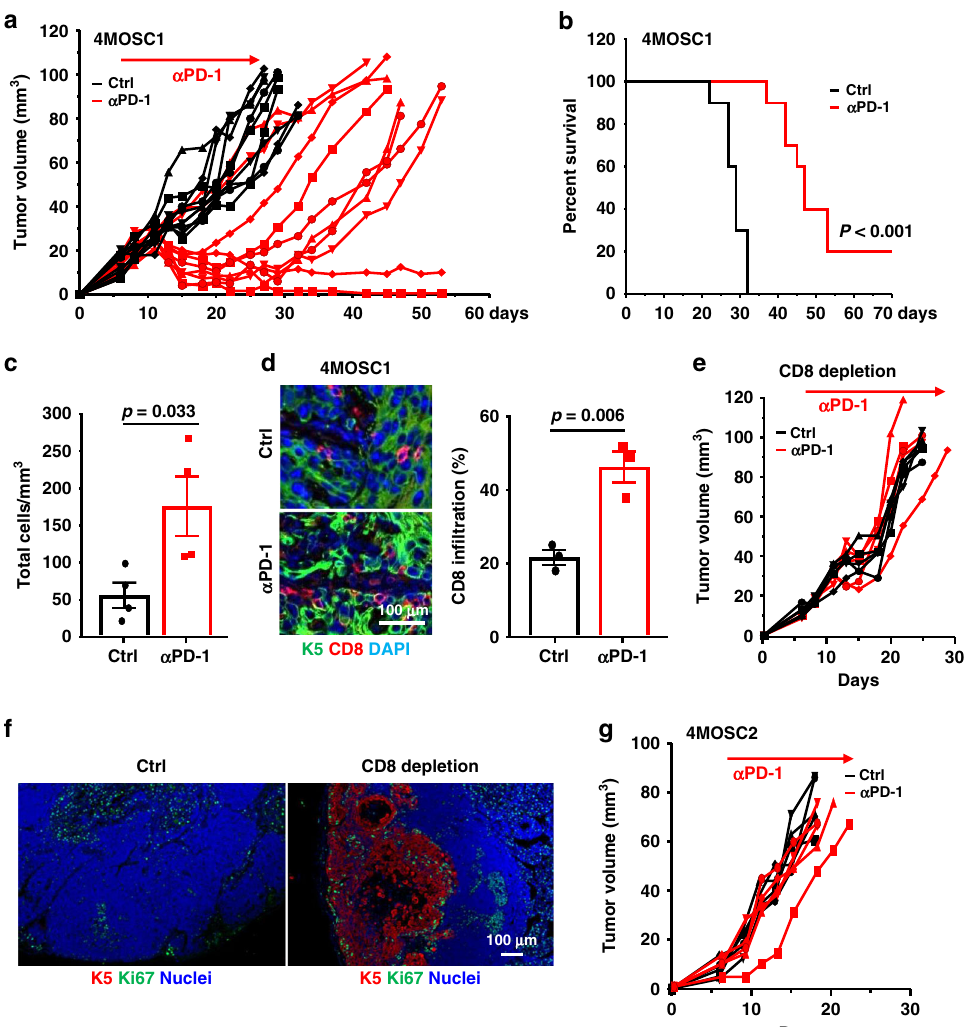
Fig. 3 Variable responses to anti-PD-1 in mice with 4MOSC1 tumors. a C57Bl/6 mice were implanted with 1 × 10 6 of 4MOSC1 cells into the tongue. After tumors reached ~30 mm 3 , mice were treated IP with 10 mg/kg of isotype control or anti-PD-1 ( n = 10 per group). Individual growth curves of 4MOSC1 tumor-bearing mice are shown. b A Kaplan – Meier curve showing the survival of mice from a . The death of animals occurred either naturally, when tumor compromised the animal welfare, or when tumor volume reached 100 mm 3 ( n = 10 mice per group; Log-Rank/Mantel – Cox test.). c Absolute number of live CD45 + CD3 + CD8 + T cells in fi ltrating 4MOSC1 tumors with or without anti-PD-1 treatment. Shown is the average of the number of live CD8 T cells in fi ltrating per mm 3 of tumor ( n = 4 mice per group; two-sided Student ’ s t test; data are represented as mean ± SEM). d Immuno fl uorescent staining of CD8 highlights an increase in CD8 T-cell recruitment with anti-PD-1 treatment. Shown is the average CD8 positivity was by three regions of interest (ROI) per mouse ( n = 3 mice per group; two-sided Student ’ s t test; data are represented as mean ± SEM). e Dependency of anti-PD-1 on CD8 T cells. C57Bl/6 mice were treated with CD8 T cell depleting antibody daily for 3 days before tumor implantation and then once a week after. Mice were then implanted with 1 × 10 6 of 4MOSC1 cells into the tongue. After tumors reached ~30 mm 3 , mice were treated IP with 10 mg/kg isotype control or 10 mg/kg anti-PD-1 ( n = 5 per group). Individual growth curves of 4MOSC1 tumor-bearing mice are shown. f Immuno fl uorescence staining of CK5 and Ki-67 in cervical lymph nodes of control or CD8-depleted 4MOSC1-bearing mice. Metastatic lesions in the lymph nodes showed abundant Ki-67 + proliferating tumor cells ( n = 5 mice per group). g C57Bl/6 mice were implanted with 1 × 10 6 of 4MOSC2 cells into the tongue. After tumors reached ~30 mm 3 , mice were treated IP with 10 mg/kg isotype control or 10 mg/kg anti-PD-1 ( n = 5 per group). Individual growth curves of 4MOSC2 tumor-bearing mice are